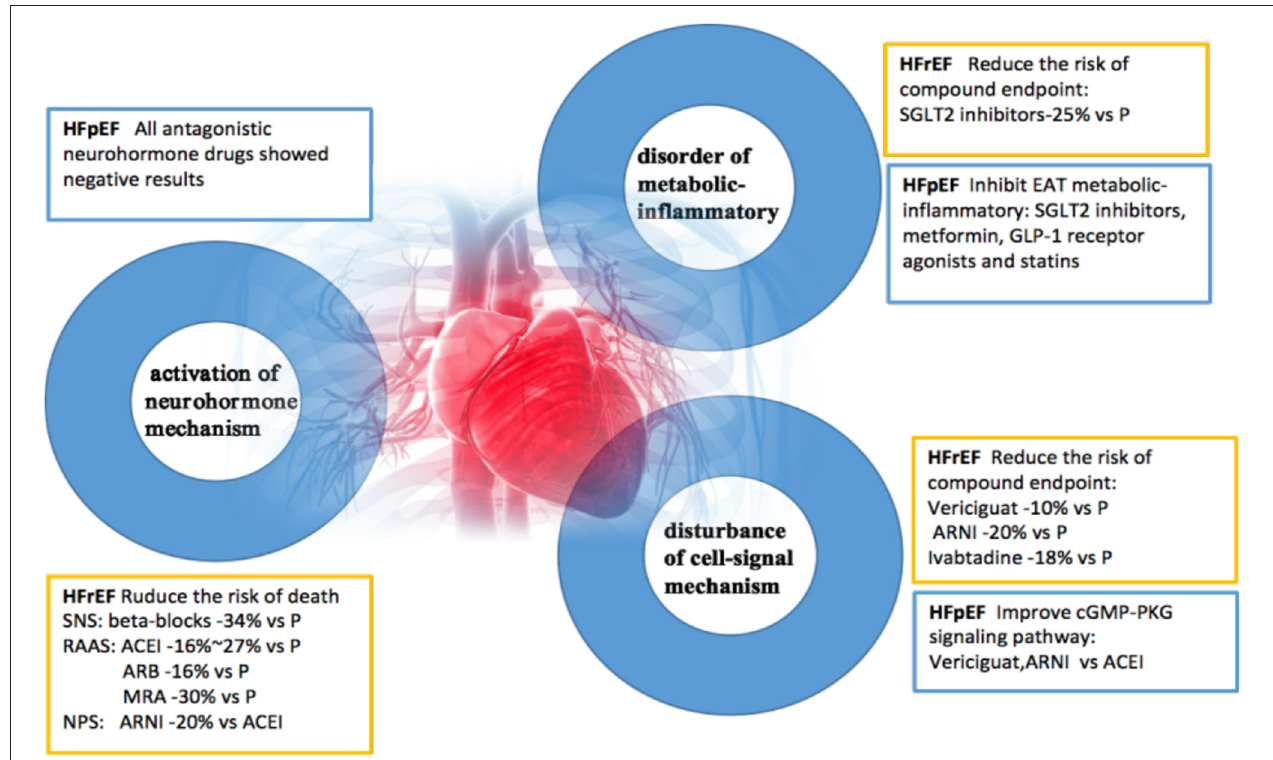
FIGURE 1 | A new understanding of pathogenesis and therapeutic benefits of heart failure. HFpEF, heart failure with preserved ejection fraction; HFrEF, heart failure with reduced ejection fraction; SNS, sympathetic nervous system; RAAS, renin-angiotensin-aldosterone system; NPS, natriuretic peptide system; EAT, epicardial adipose tissue; ACEI, angiotensin-converting enzyme inhibitor; ARB, angiotensin receptor antagonist; MRA, aldosterone receptor antagonist; P, placebo; ARNI, angiotensin receptor enkephalinase inhibitor; SGLT2, sodium-glucose cotransporter 2; GLP-1, glucagon-like